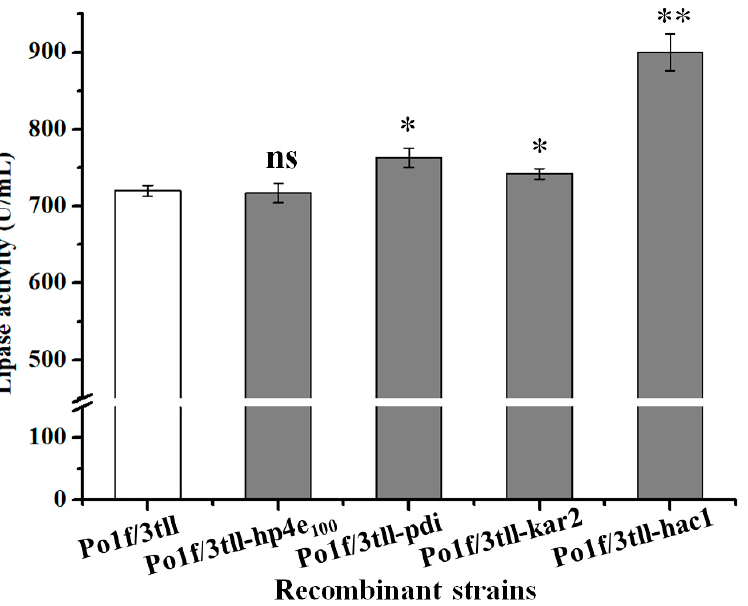
Figure 6. Effect of co-expressing a single folding-related helper protein on TLL production in the strain Po1f/3tll. Statistical significance was calculated by unpaired T-test analysis. ns: no significant difference; *: p < 0.05; **: p < 0.01.